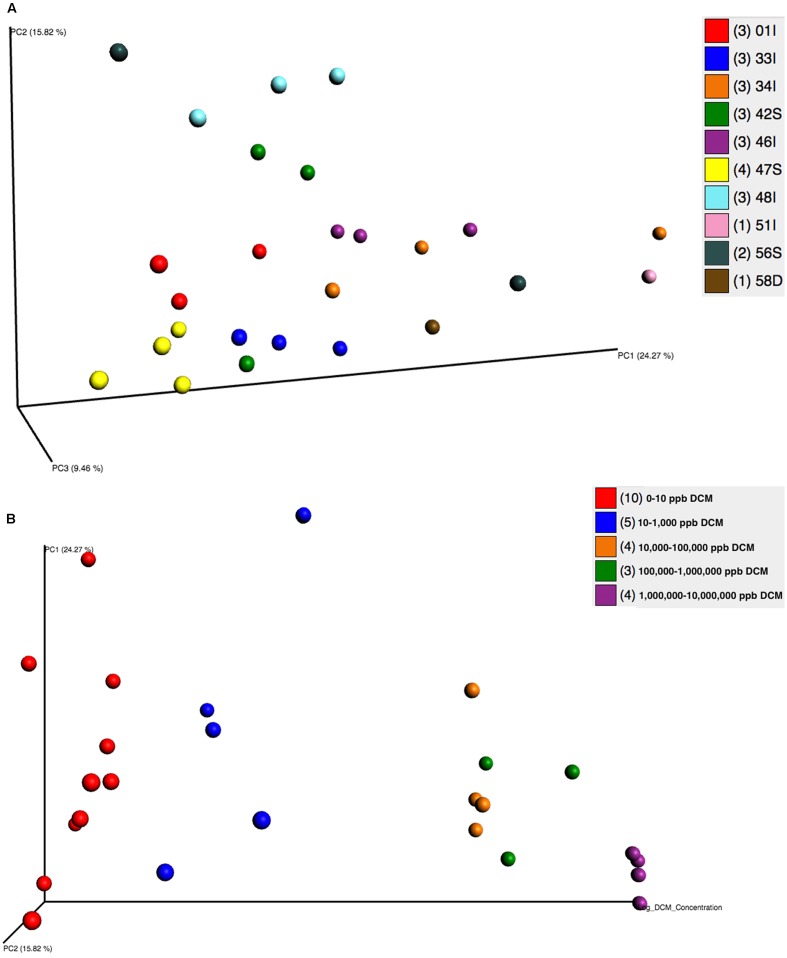
(A,B) Principal Coordinates Analyses (PCoA) plots were utilized to visualize differences in microbial community structure between groundwater samples grouped by well (A) and DCM concentration (B). PCoA plots were generated from a weighted UniFrac distance matrix calculated within QIIME 1.9.0. (A) Samples are colored based on sampling well. Distinct clustering of samples can be observed within wells 01I (red), 33I (blue), 46I (purple), 47S (yellow), and 48I (teal). Sample clustering based on well was considered to be significant (ANOSIM, p = 0.001) and accounted for 55% of variation in microbial community structure between samples (adonis p = 0.001). (B) A directional PCoA plot distributes samples along the x-axis by increasing DCM concentrations that underwent log + 1 transformations. Clustering of samples with higher DCM concentrations can be observed. DCM concentration (μg/L) was found to cause significant shifts (10%, adonis p = 0.004) in microbial community structure. Variability between samples significantly decreases as DCM concentrations rise (Z score = 3.17, Mann–Whitney U P1 = 0.0009, P2 = 0.015), indicative of a shaping toward a defined microbial community structure as DCM increases.